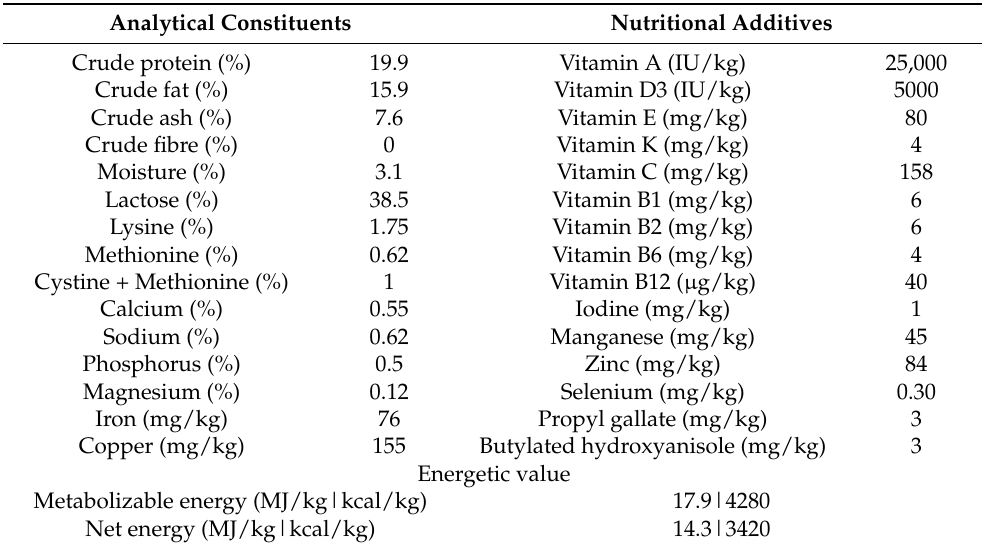
Table 1. Nutrient, chemical and energetic composition of the supplemented milk